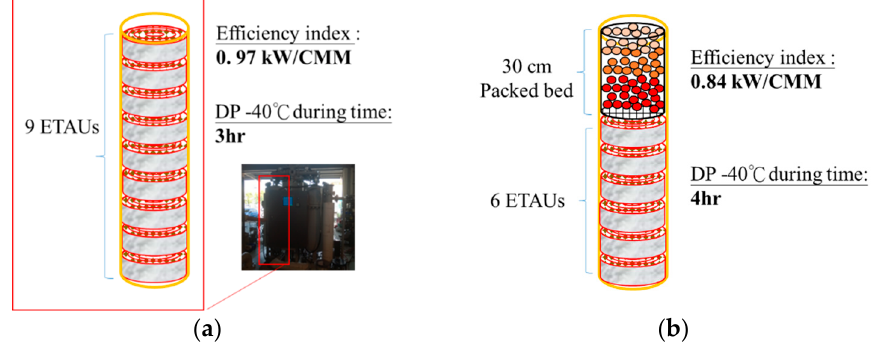
Figure 18. Schematic diagram of ( a ) ETAU system and ( b ) composite ETAU system.